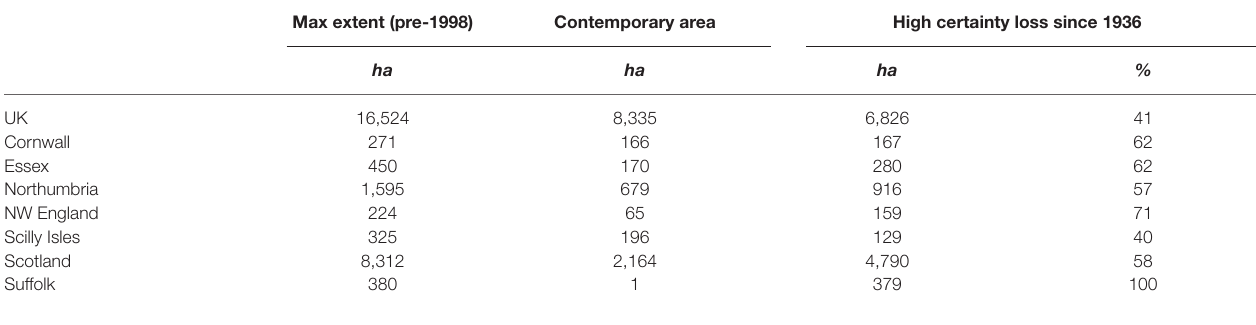
TABLE 3 | High certainty seagrass loss (by area and percent reduction) in regions where good historic data are available based on the systematic review.